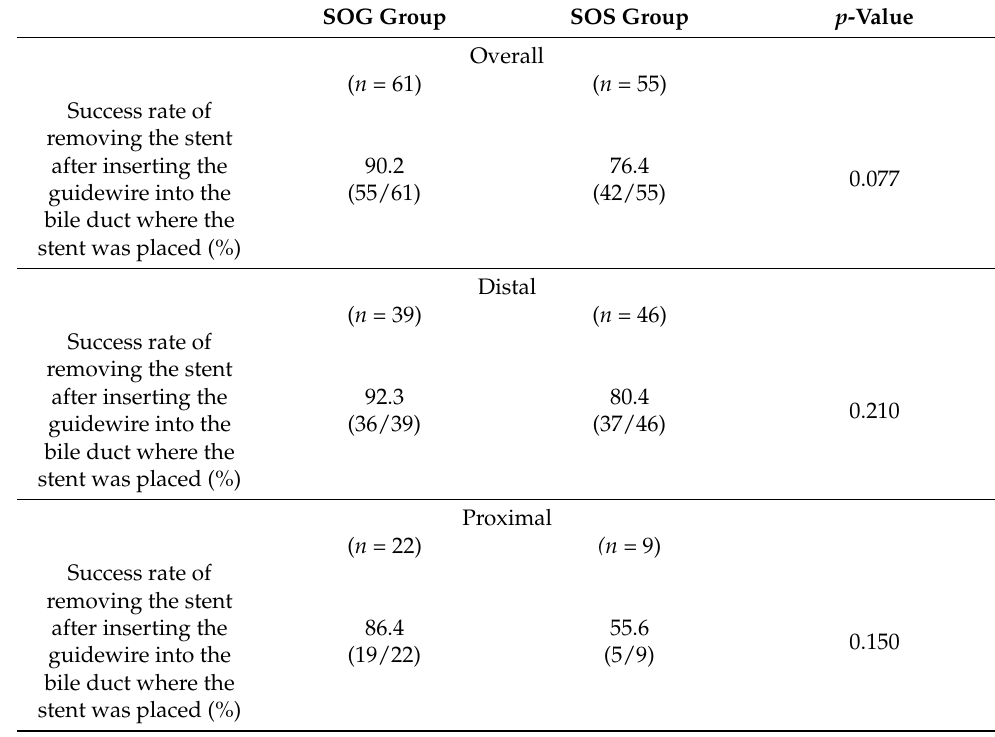
Table 3. Comparison of procedural success rates between the two groups (only in cases where the PS to be replaced was straight). SOG Group SOS Group p -Value